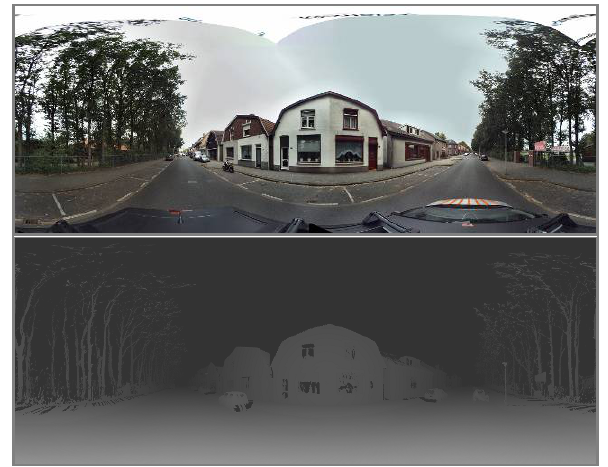
Figure 4. An example of a panoramic image and a grayscale representation of its corresponding depth